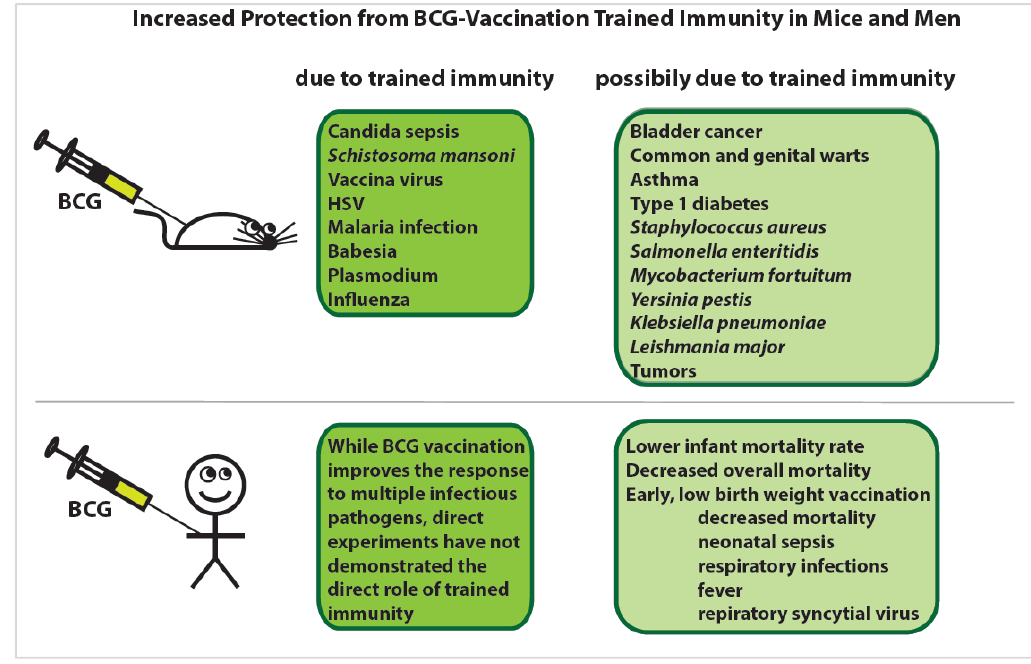
Figure 4. The proven and possible training effects of Bacillus Calmette–Guerin (BCG) vaccination. While BCG vaccination results in increased protection against a variety of pathogens due to trained immunity in both mice and humans (dark green boxes), the severity of multiple other diseases and pathologies is known to be abrogated by BCG vaccination, but this may be due to either innate trained immunity or lymphocyte-mediated heterologous effects (light green